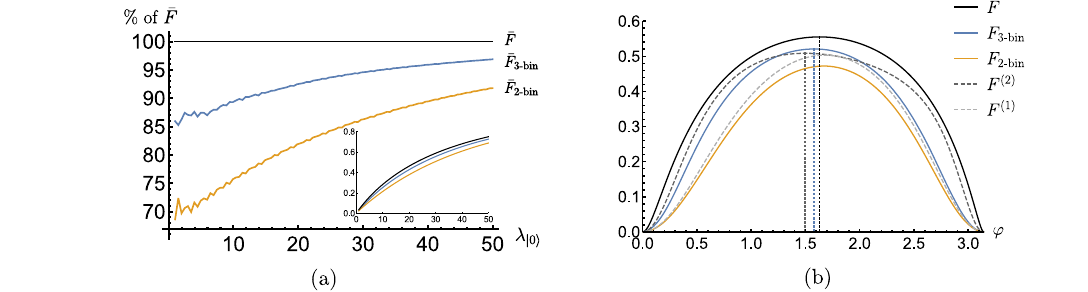
F 3-bin – blue) presented now as a function of the input state angle ϕ = φ − θ (for = λ ∣ : 65 and λ ∣ λ ∣ 76 ) in comparison to the lower bounds on F constructed 1 i 0 i =0 0 i =27 by taking into account up to the second ( F (1) , light gray dash) and fourth moment ( F (2) , dark gray dash) of the distribution describing the observed outcomes, q θ Theverticaldottedlinesindicatethe(optimal)stateangleateachoftherespective quantitiesismaximised. Notethat whenthe measurement is perfect, the FIisunity for all choices of the angle φ (not